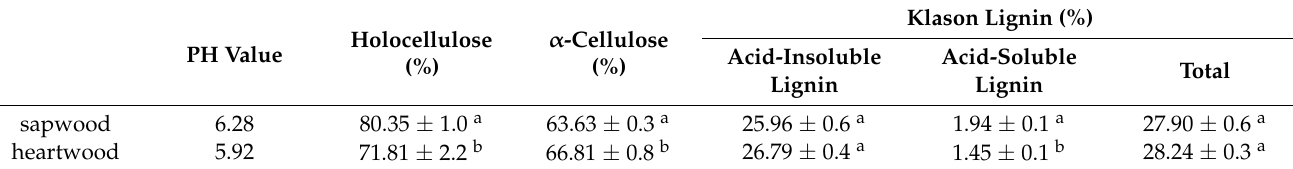
Table 1. Main chemical components of sapwood and heartwood of D. oliveri.